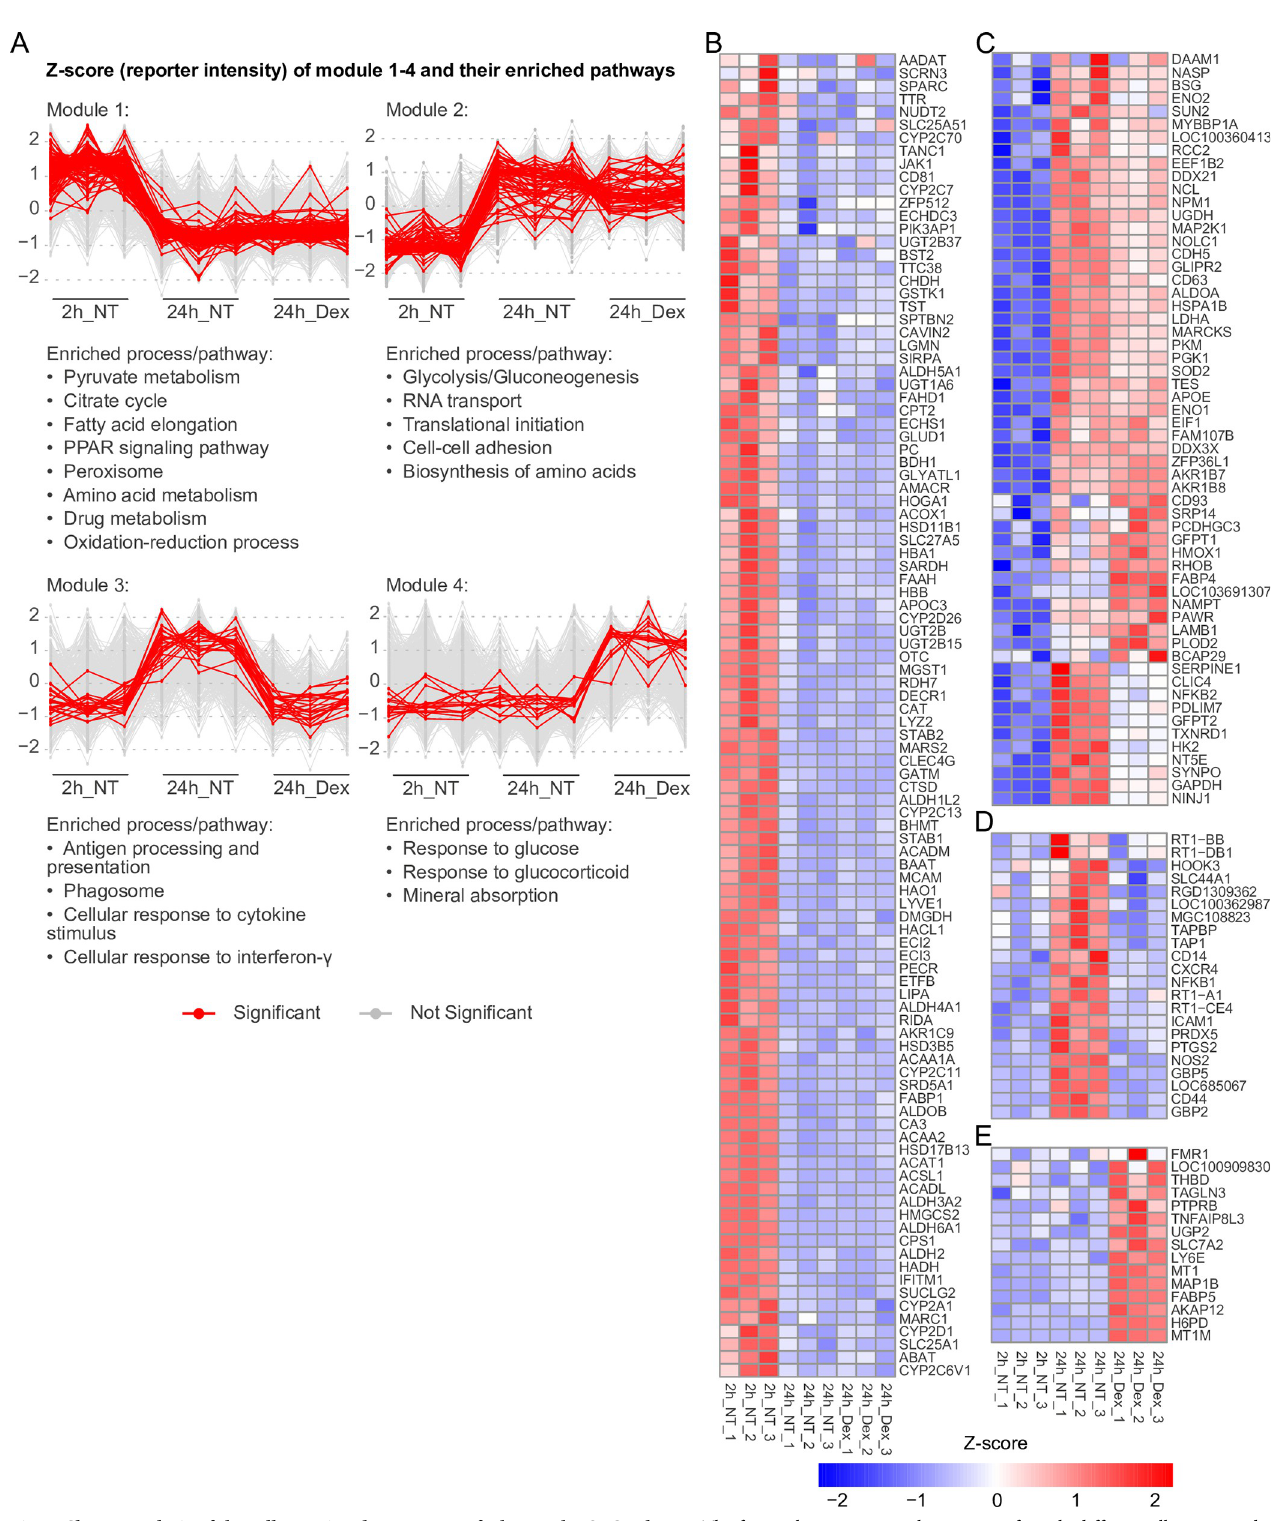
Fig 3. Cluster analysis of the cell-associated proteomes of 2 h vs 24 h LSEC cultures. The figure shows proteins that are significantly differentially expressed between rat LSEC cultures at 2 and 24 h post seeding. (A) Row-wise k-means clustering on the whole cell lysate proteome of non-treated LSECs